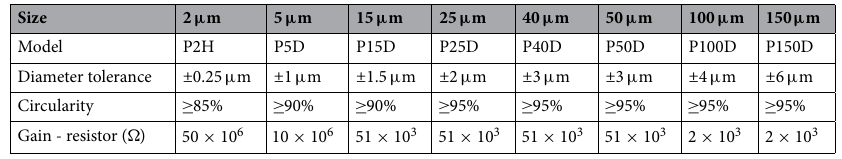
Table 1. Ch 1 aperture stops parameters.